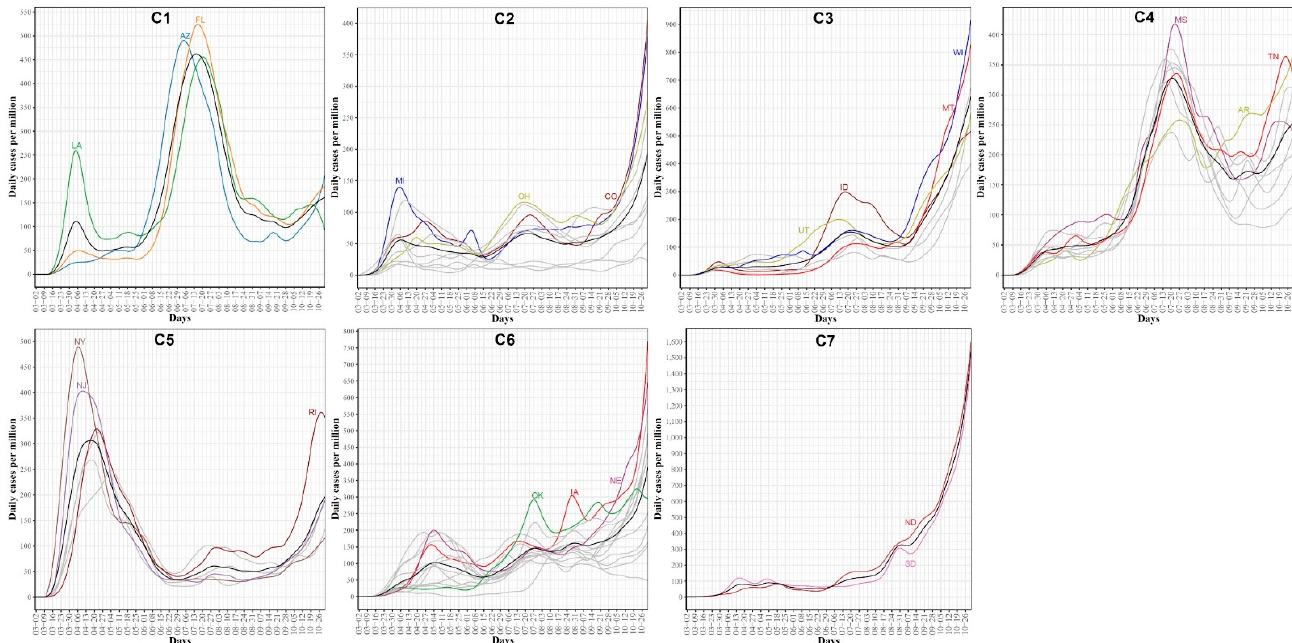
Figure 10. COVID-19 confirmed case trajectories of the states in each cluster. The mean curve for the states in each cluster is highlighted in black.